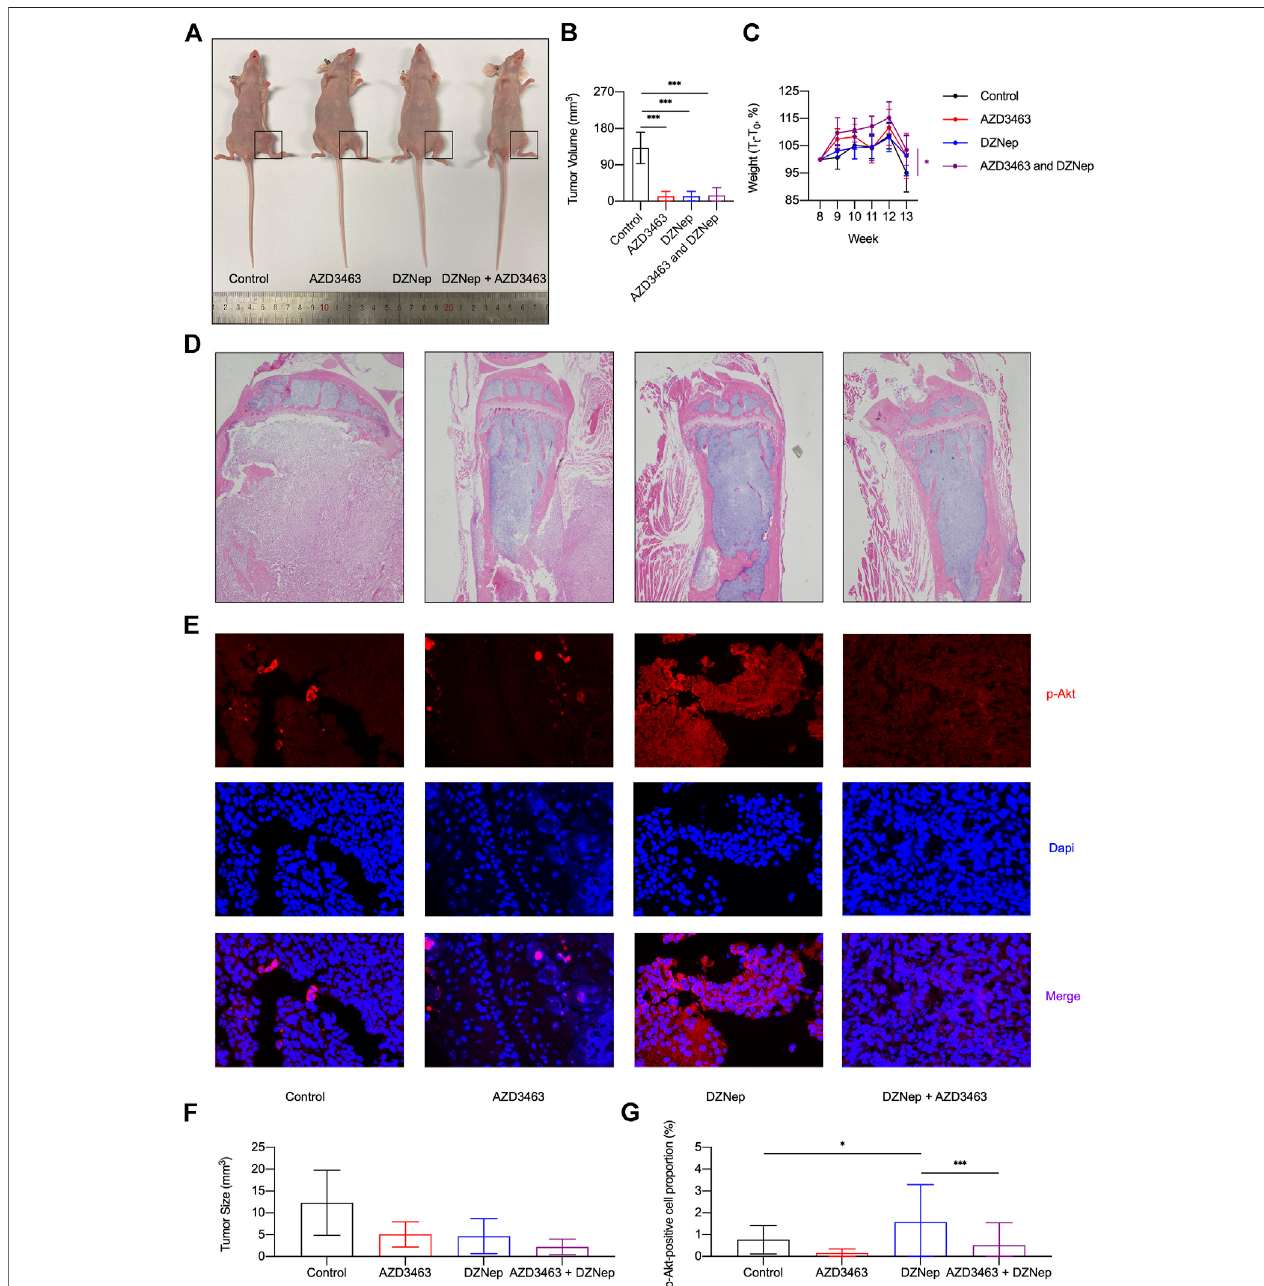
FIGURE 7 | Effects of DZNep and AZD3643 on breast cancer bone metastasis in vivo . (A,B) Representative images of tumor model mice. Tumor volume of 13 week-oldmicesigni fi cantlydecreasedinAZD3463,DZNep,andcombinationgroupscomparedtothecontrolgroup. (C) Standardizedbodyweight(T t /T 0 ,%)ofmice from week 8 (T 0 ) to week 13 showing that DZNep and AZD3463 reduced weight loss. (D,F) Representative images and bar graph of hemotoxylin and eosin (H&E) stainingofcancerousbone. (E,G) Representativeimagesandbargraphofimmuno fl uorescence(IF)stainingof p -Akt(red),DAPI(blue),andmergedresults(purple).